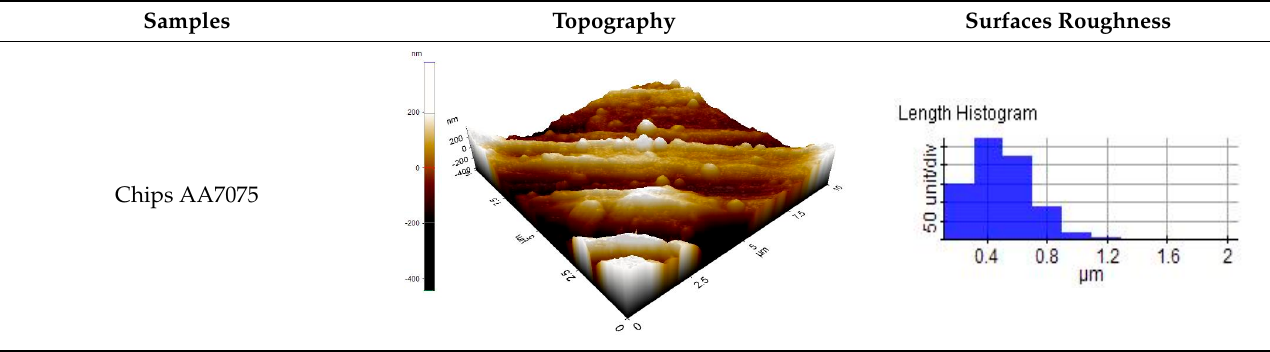
Table 11. AFM topography images of recycled samples. Topography